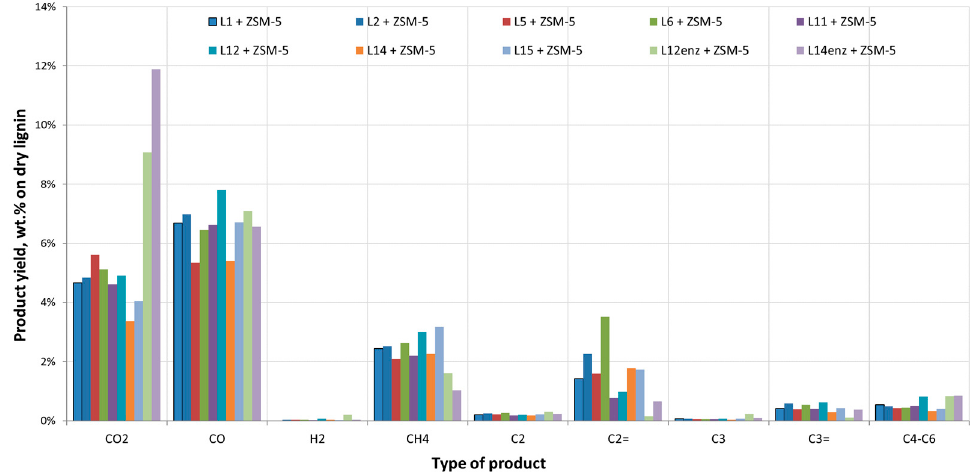
Figure 4. Individual gas yields (dry basis) from catalytic pyrolysis of organosolv-derived beechwood lignins.